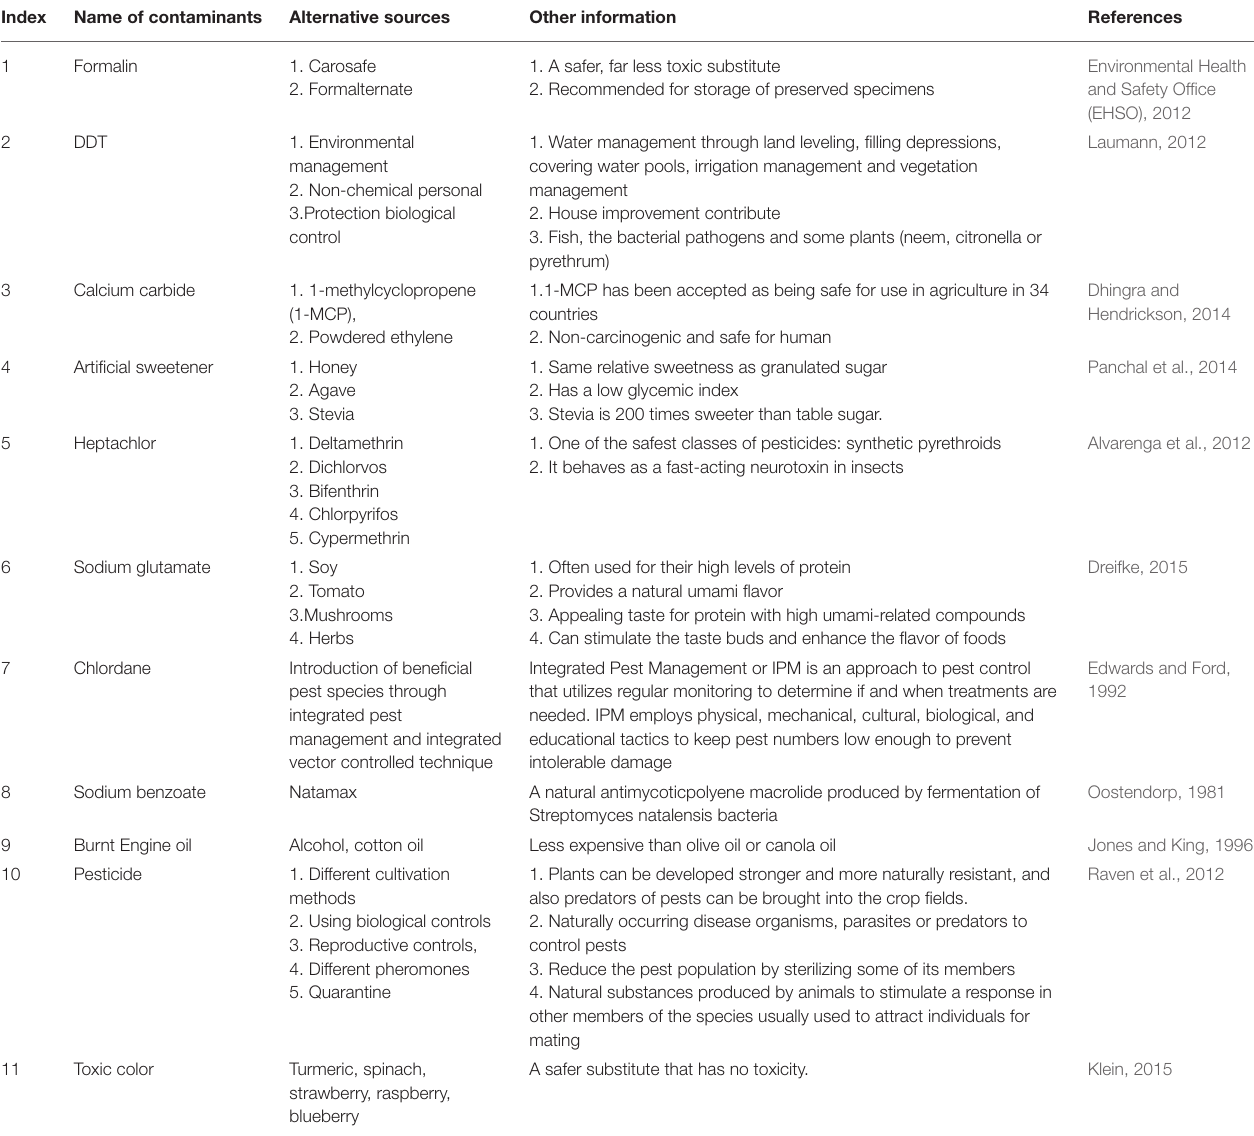
TABLE 5 | Natural alternatives for certain food adulterants, contaminants and